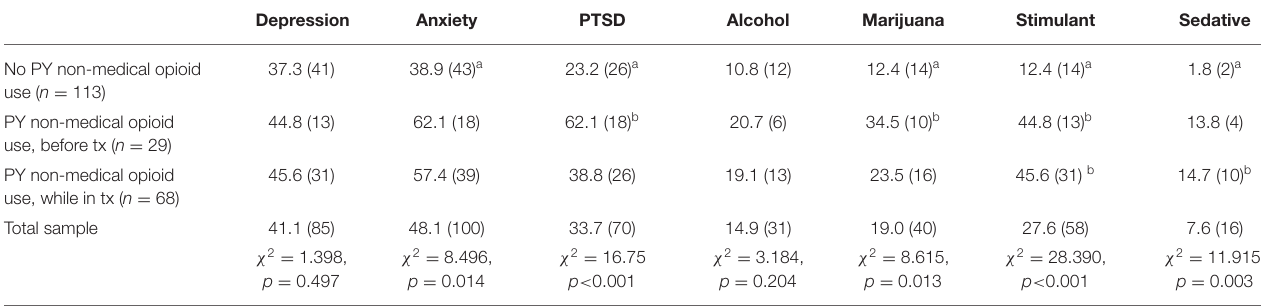
TABLE 3 | Group differences for comorbid disorders by past-year non-medical opioid use status. Depression Anxiety PTSD Alcohol